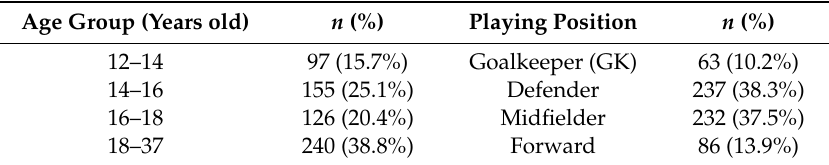
Table 1. Distribution by age group and playing position of the